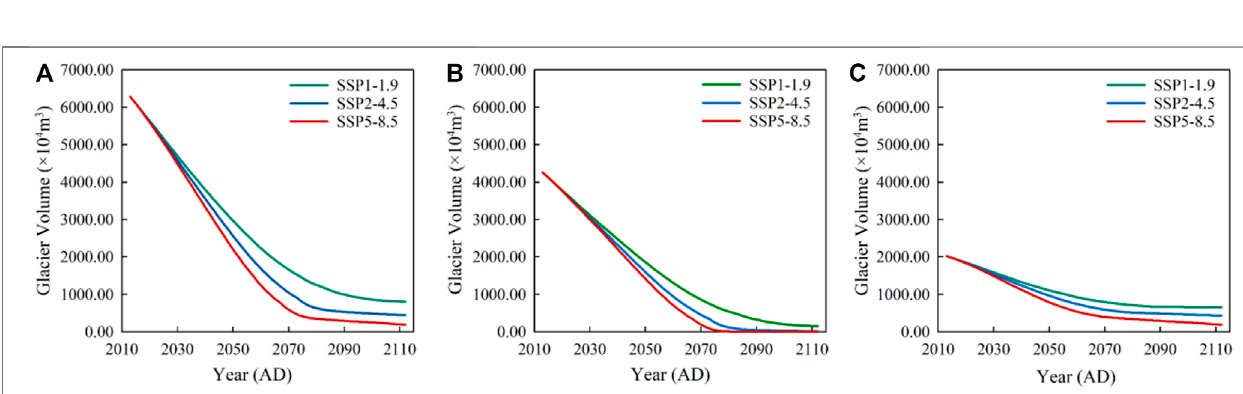
FIGURE11| Simulated icevolume oftheglacierasafunctionoftimeinthethreeclimatescenarios: (A) theicevolumeoftheentireglacier; (B) theicevolumeofthe EB; and (C) the ice volume of the WB.